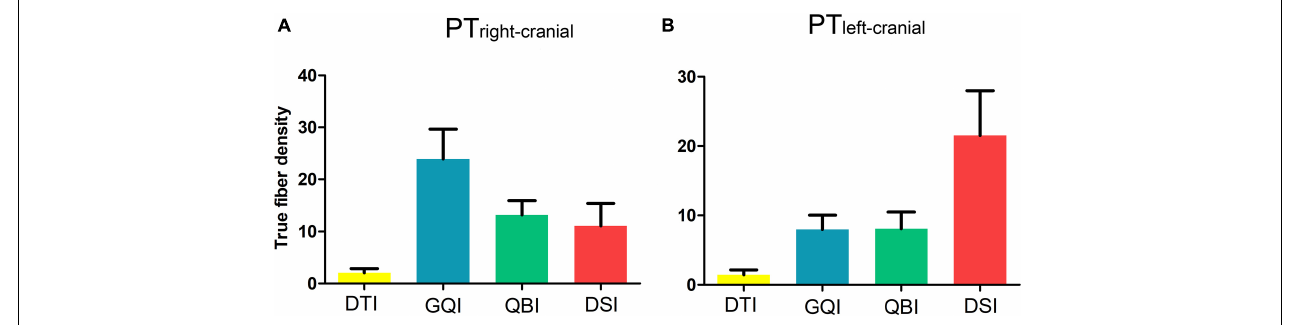
FIGURE 6 | Comparison of the density of true fibers in PT cranial . (A) The true fiber density of the right PT cranial . (B) The true fiber density of the left PT cranial . DTI, diffusion tensor imaging; DSI, diffusion spectral imaging; GQI, generalized Q-space sampling imaging; L, left; PT, pyramid tract; QBI, Q-ball imaging; R, right. The error bar represents standard errors.